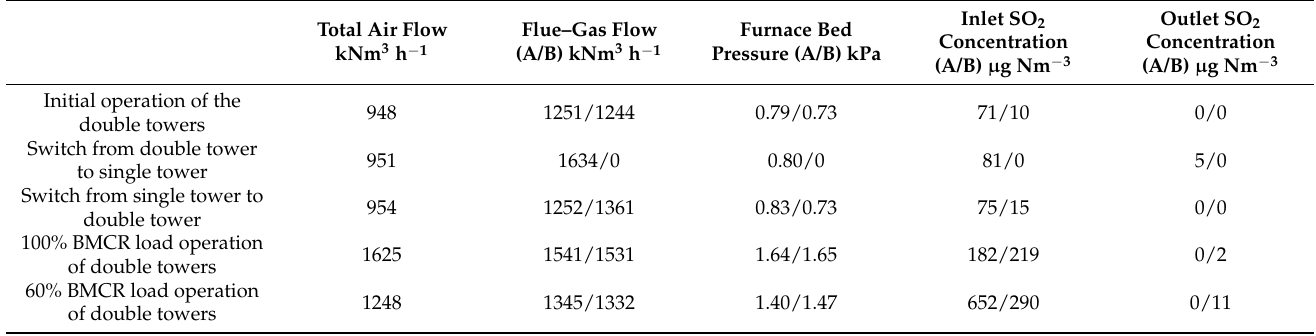
Table 3. Test results of switching between single and double desulfurization towers.